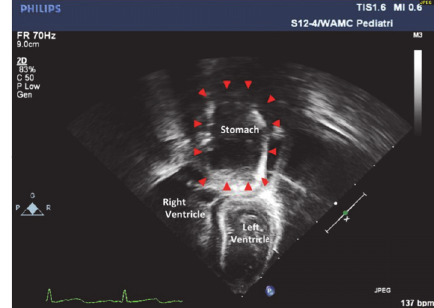
Figure 1: Modified apical 4-chamber view (posterior angulation) showing the stomach (arrowhead) above the left ventricle in the thorax outside of the pericardium.